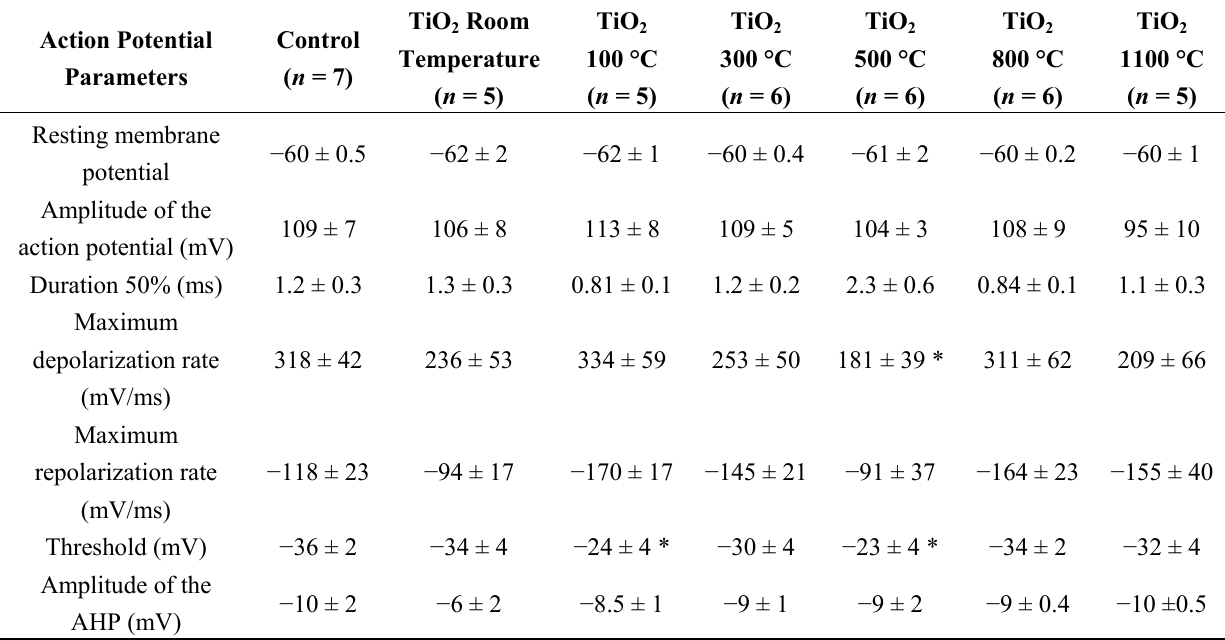
Table 3. Properties of action potentials of DRG neurons grown on control substrate and TiO thin 2